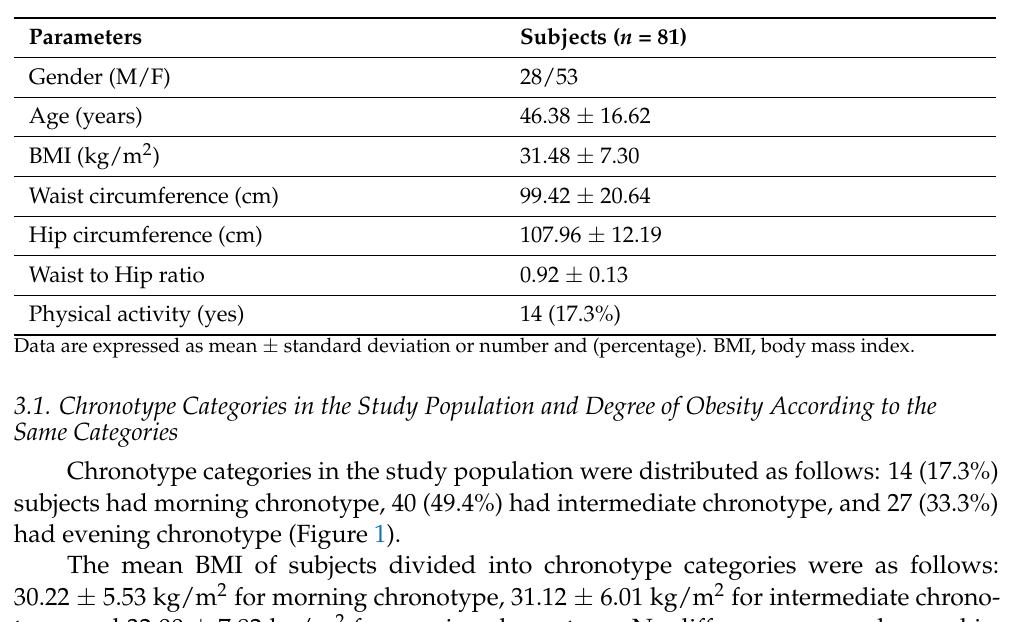
Table 1. Main characteristics of the study